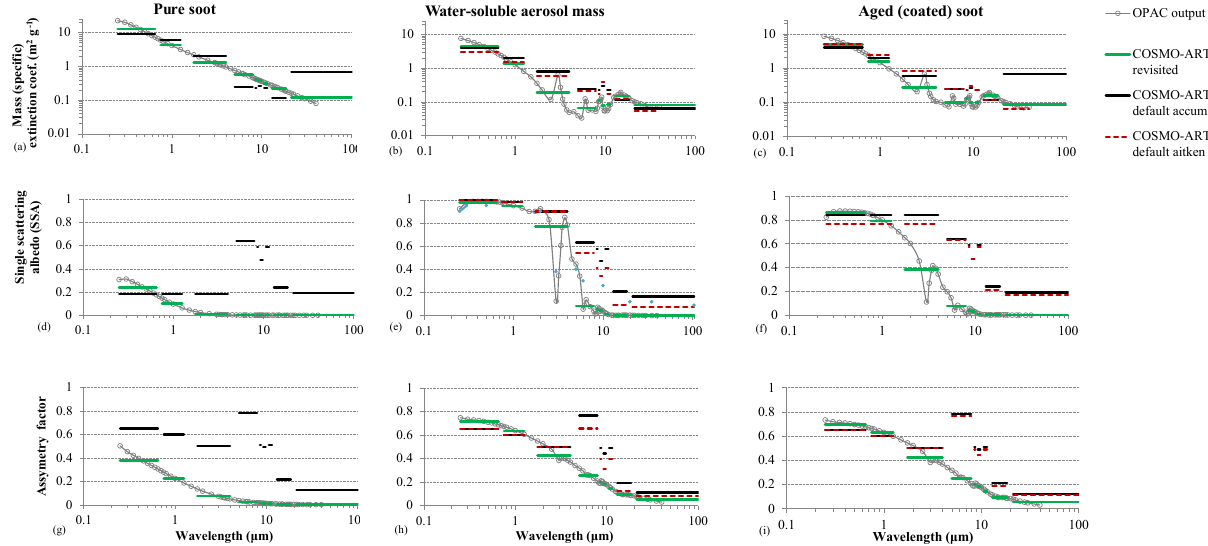
Figure 3. Specific extinction coefficient (a–c) , single scattering albedo (d–f) and asymmetry factor (g–i) per wavelength for different mixtures of submicron aerosol (pure soot, water-soluble mass and coated soot) from the COSMO-ART configuration described in Vogel et al. (2009; black and red lines for the accumulation and nucleation mode, respectively; soot is represented by a single mode), from the OPAC algorithm (grey lines), and from the OPAC values adjusted to the COSMO-ART bands (green lines).